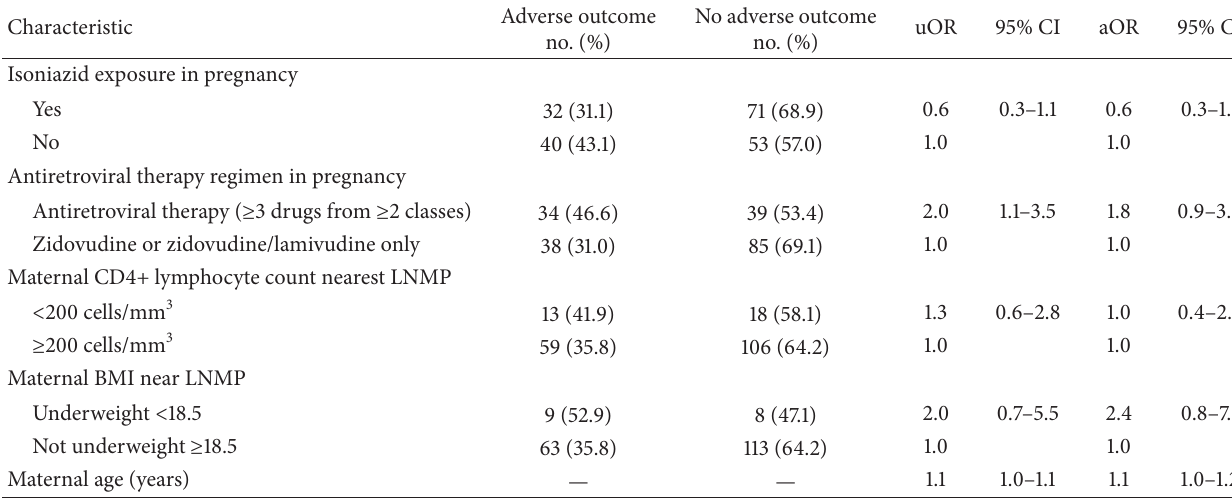
Table 2: Association between adverse pregnancy outcomes and isoniazid and/or antiretroviral therapy during pregnancy in HIV-infected women, Isoniazid Preventive Therapy Trial, Botswana, 2005–2008 ( 𝑛 = 196 ).